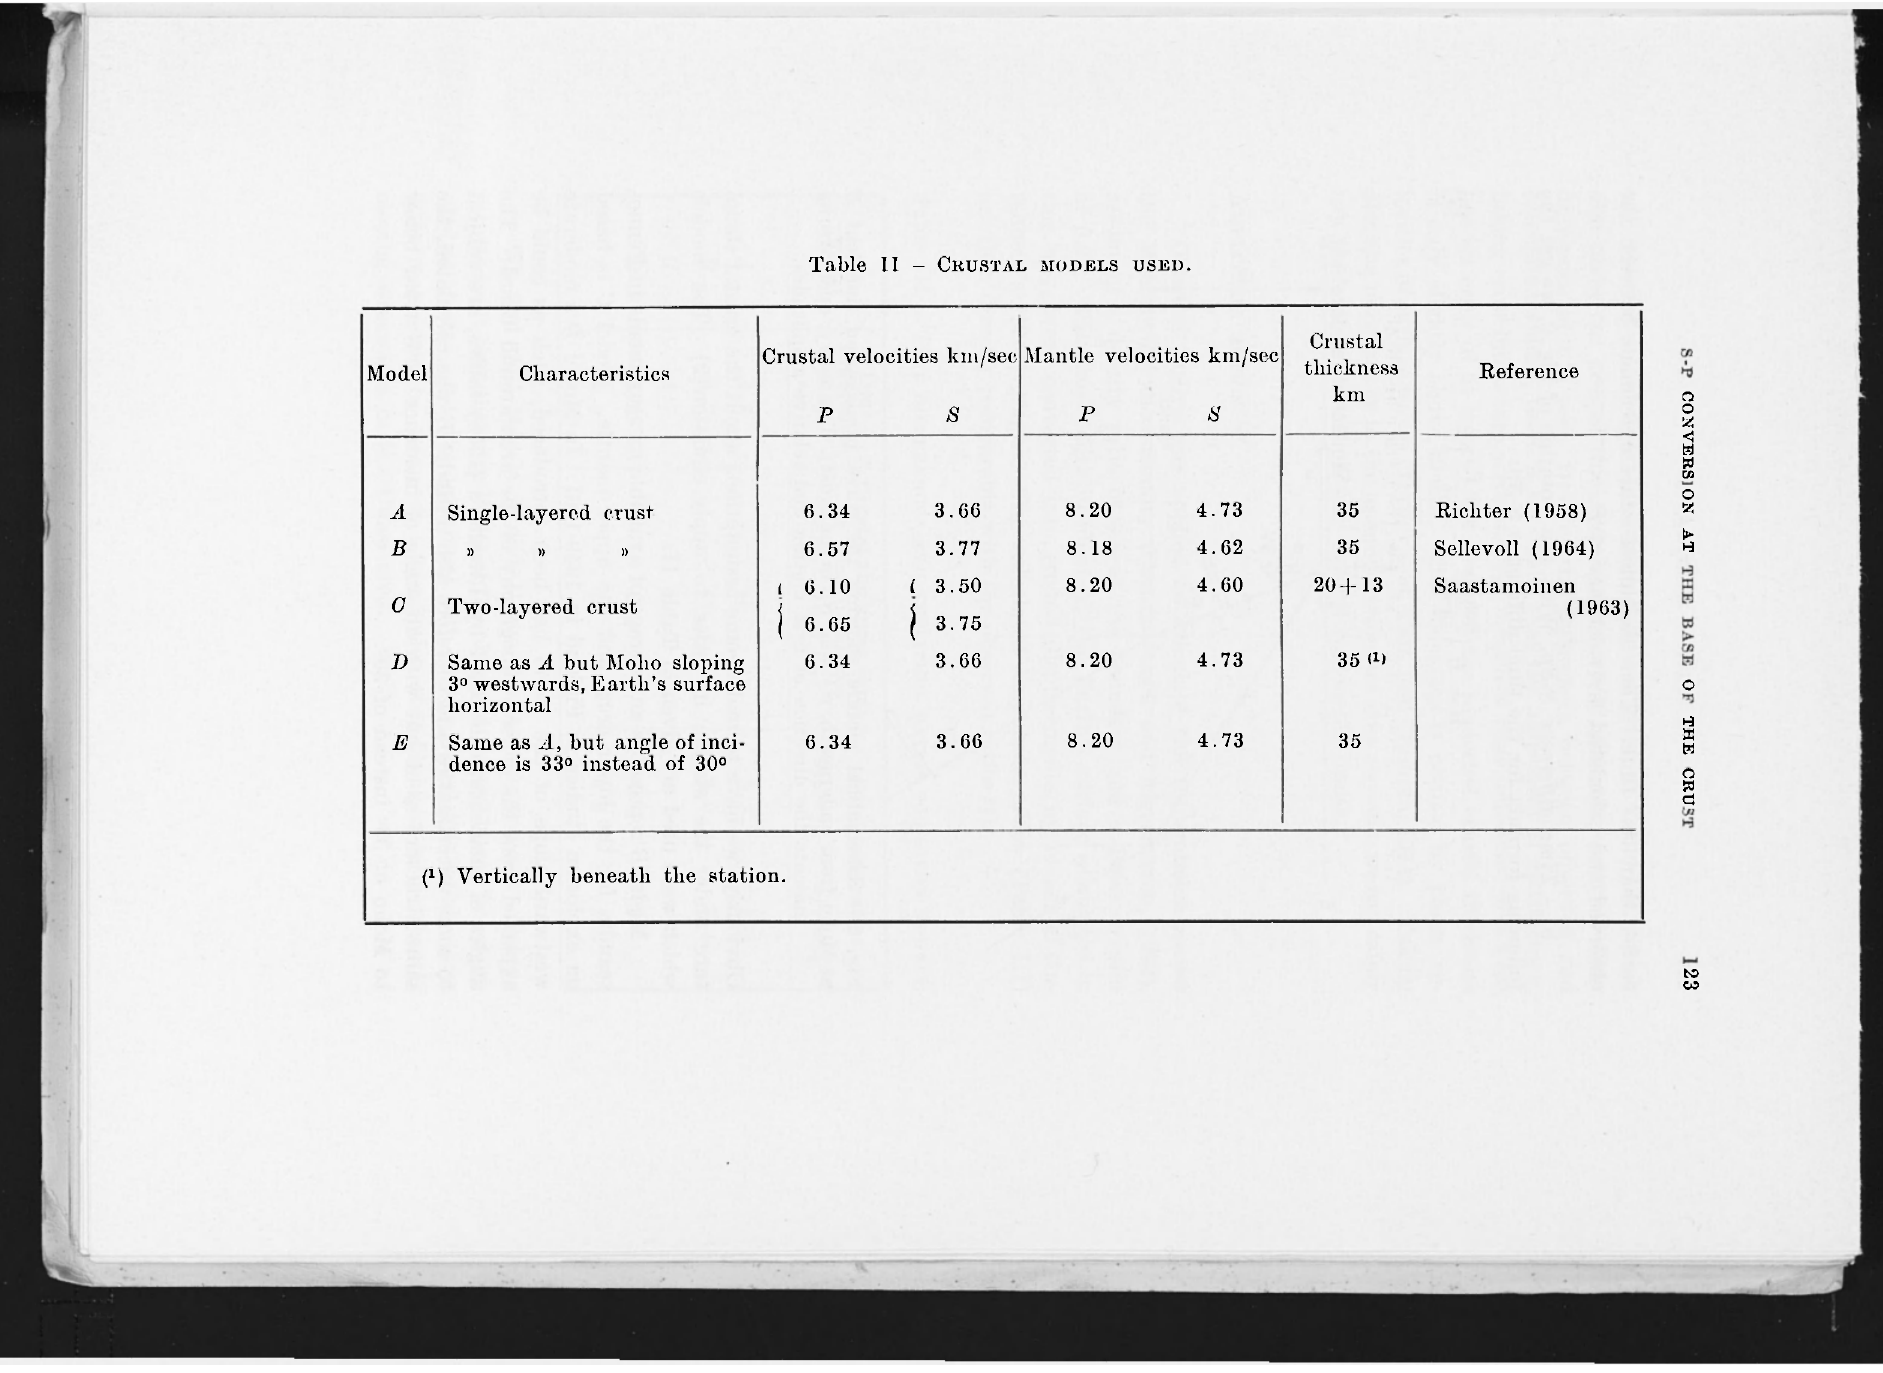
Table II - CRUSTAL MODELS